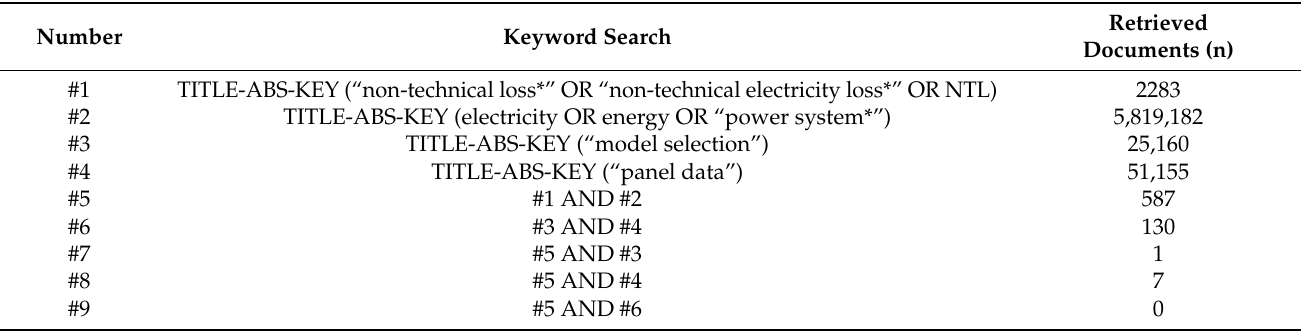
Table A2. Search strategy in the Scopus